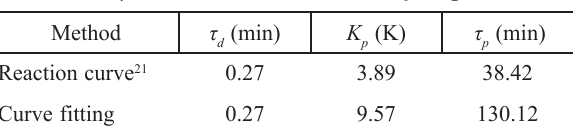
Table 4 – Parameters of system identification model obtained by the reaction curve and curve fitting methods Method